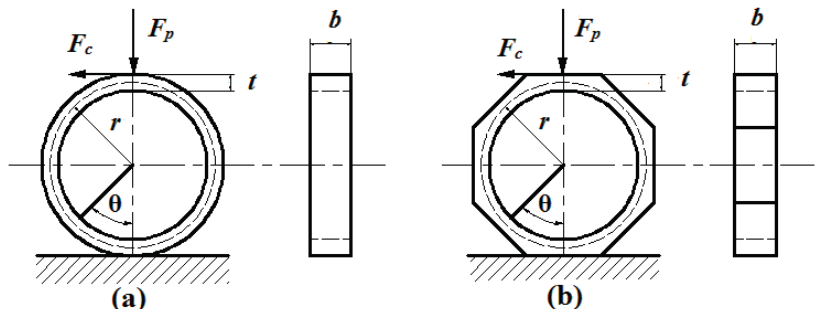
Figure 2. ( a ) Schematic view of a circular ring under the effect of F p and F c ; ( b ) Schematic view of an octagonal ring under the effect of F p and F c .